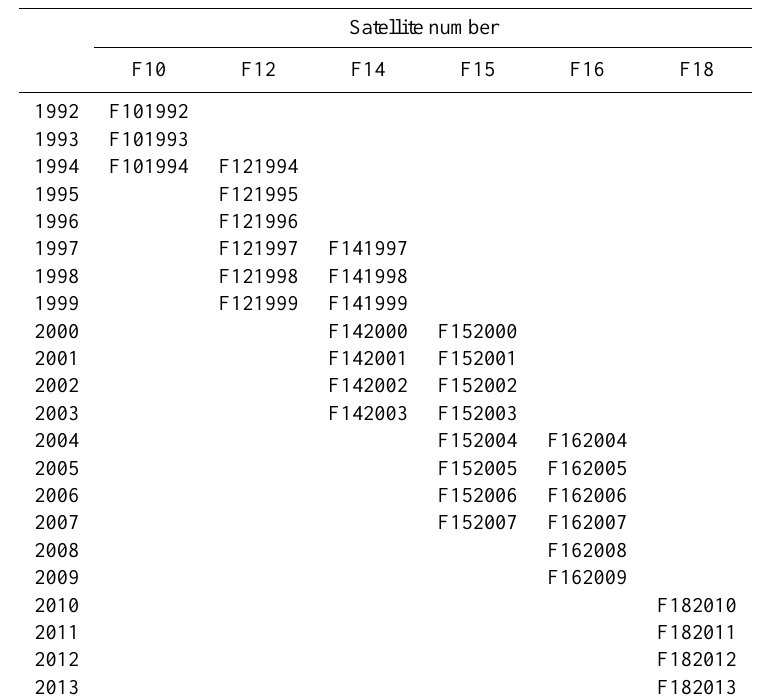
Table 1. Nighttime lights data set, satellite number and observation